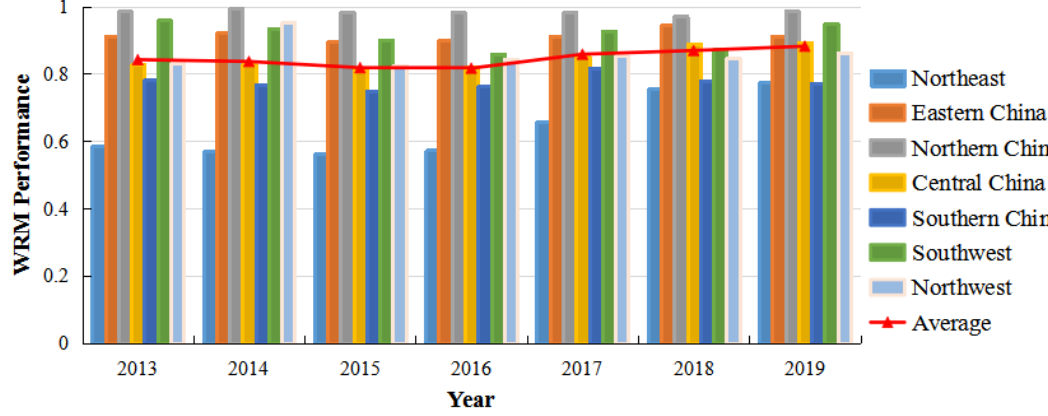
Figure 3. Change in the WRM performance of the different regions in China .